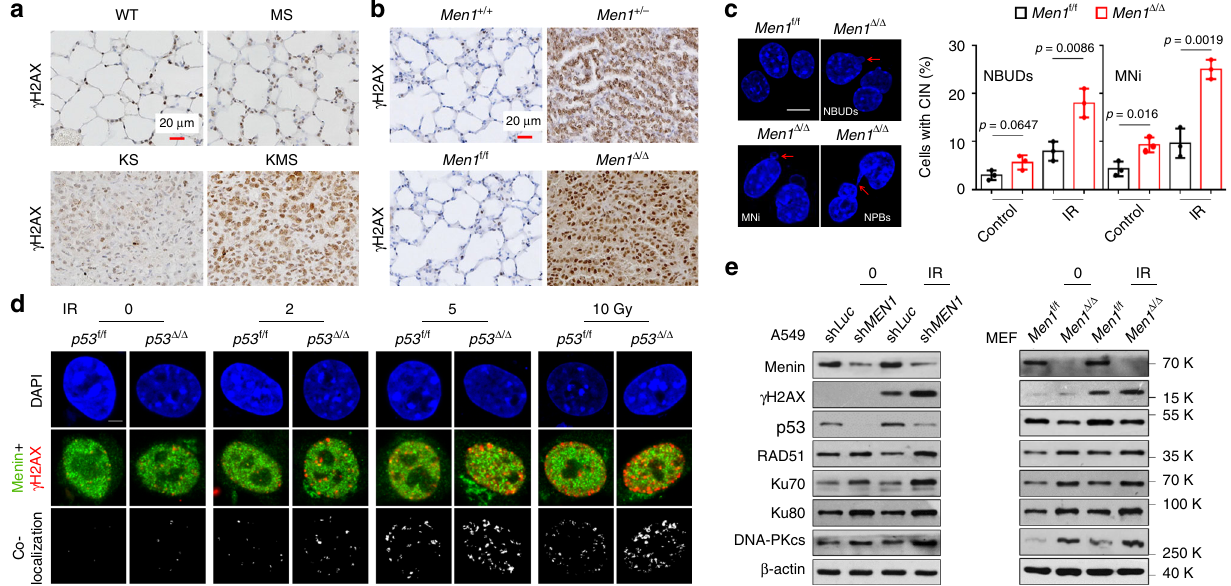
Fig. 4 Loss of Men1 triggers aberrant DNA damage repair. a , b IHC staining for γ H2AX was performed in lung tissue/tumor sections from mice of the indicated genotypes. a The WT, MS, KS, and KMS 11 weeks mice lung tissues. b The Men1 + / − 18 months mice lung tissues and the Men1 Δ / Δ 12 months mice lung tissues. Scale bars, 20 μ m. c Representative images of DAPI staining showing NBUDs, NPBs, and MNi (red arrows) in Men1 f/f and Men1 Δ / Δ MEF cells 1 hour after exposure to 10 Gy of IR. The statistical results were obtained from analysis of mitotic cells( n = 100 per group), and repeat the count three times. Scale bars, 10 μ m. d IF staining for γ H2AX (red), menin (green), and DAPI (blue) in p53 f/f and p53 Δ / Δ MEF cells 1 hour after exposure to the indicated IR dose. Colocalization of menin and γ H2AX is shown in gray. Scale bars, 10 μ m. e Western blotting was used to detect the expression of the indicated proteins in A549 and MEF cells 1 hour after exposure to 10 Gy of IR. Data are represented as mean ± SD in c . Signi fi cance determined by two- tailed unpaired t tests in c are indicated. Results in c , d , and e are representative of three independent experiments. Source Data are provided as a Source Data fi